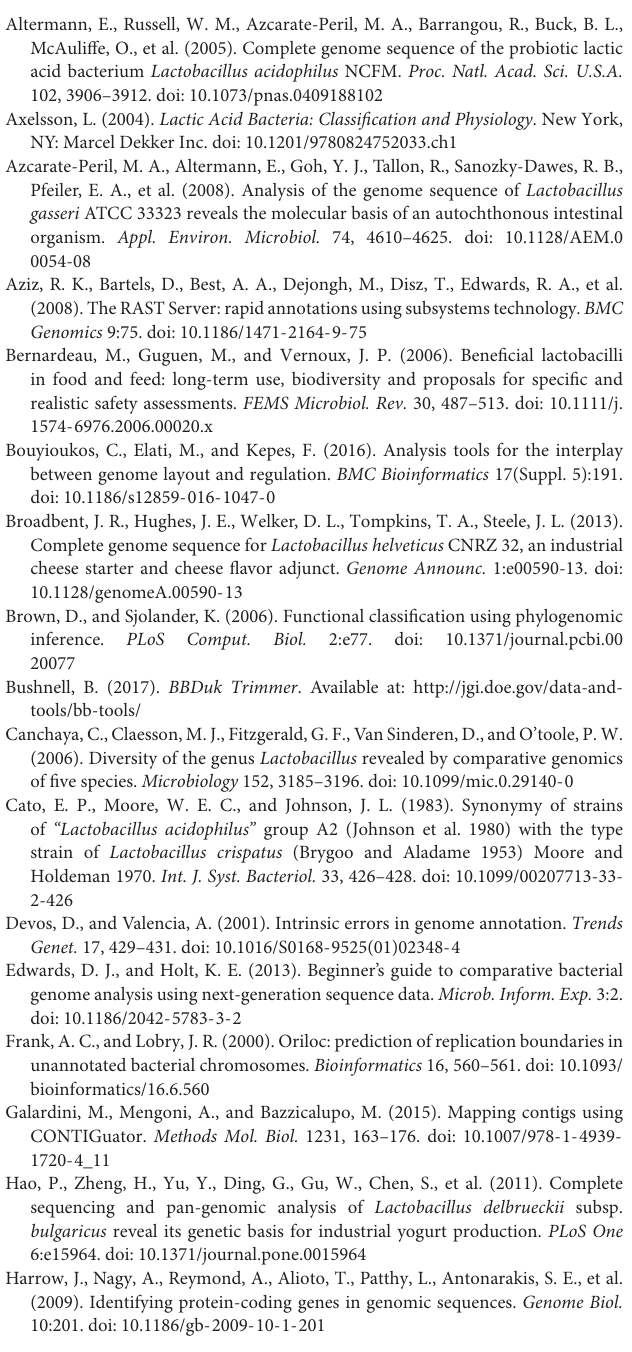
training set. The lower left plots show the scatter plot and best fit line for each pairwise comparison. The histograms across the diagonal of each matrix show the distribution of the core genome. The R 2 value for each correlation is given in the upper right boxes and the number of stars depict the statistical significance of the correlation, ( ∗∗∗ p < 0.0001; ∗∗ p < 0.001; ∗ p < 0.05). FIGURE S2 | Distribution of core genome compared to non-core genome by organism. The distribution of the core genome (gray bars) to non-core genome